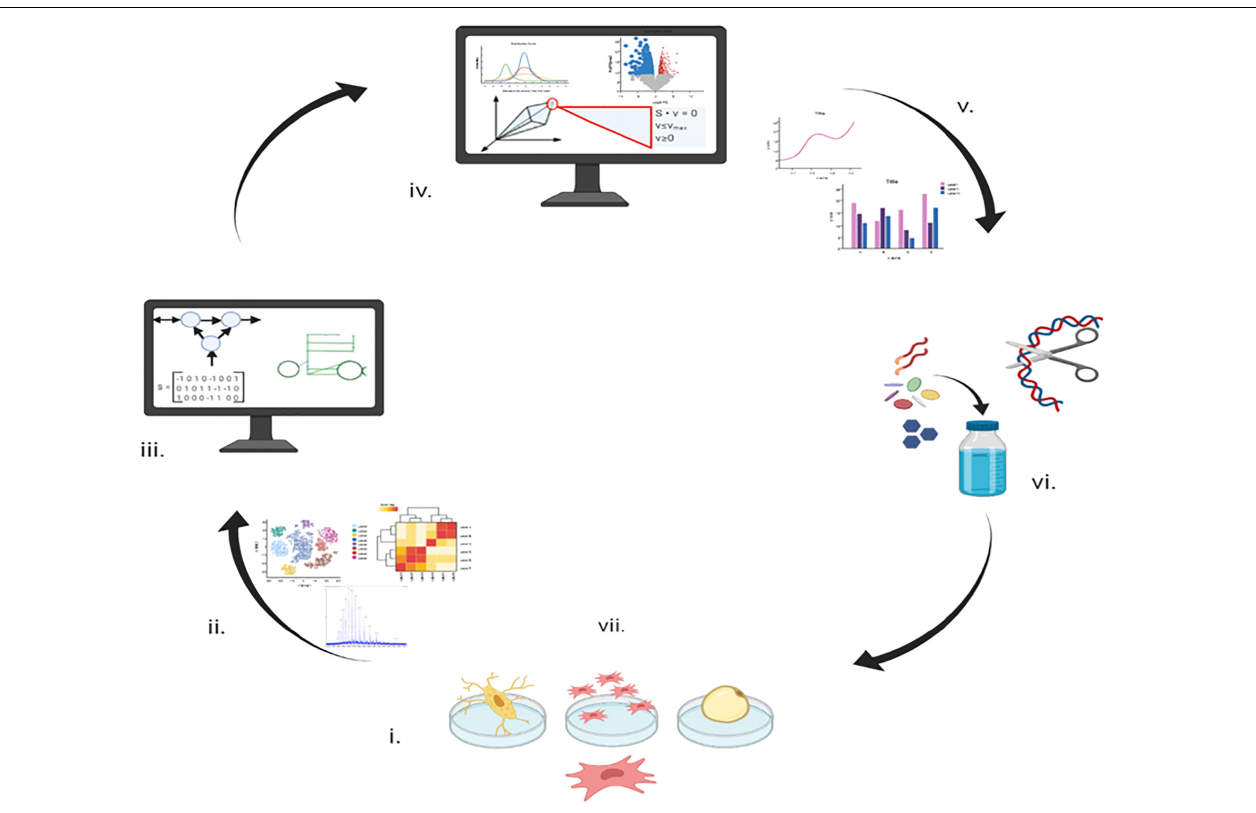
FIGURE 1 | A schematic drawing showing how metabolic modeling can integrate data to contribute to planning future experiments and potential utilization. Stage (i) Initial metabolomics and transcriptomics data acquisition from in vitro culture. Stage (ii) Statistical analysis of metabolomic and transcriptomic data. Stage (iii) Reconstruction of the human metabolic network from the literature and previous knowledge. Stage (iv) Application of metabolic and transcriptomic data to the metabolic network to produce context specific models. Stage (v) Analysis of the differences between the three biological models. Stage (vi) Verification of novel findings of the models initially through comparison to the results of published experiments (presented in this manuscript) and then through new experiments. Stage (vii) Improved knowledge of the biological system enabling optimized growth and differentiation that may be applied to improve healthcare or industrial